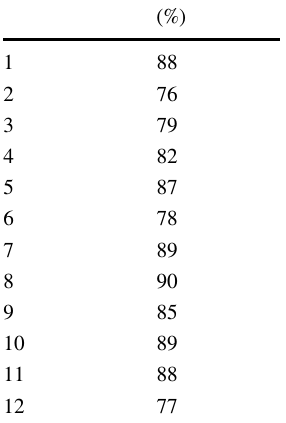
Table 2 Rounded amounts of correlation between seismic and well log data in the drilled well locations